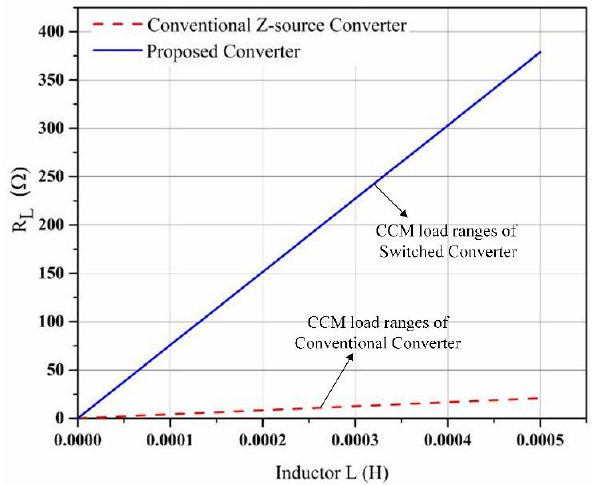
Figure 12. Load range for the proposed converter and traditional Z-source converter.